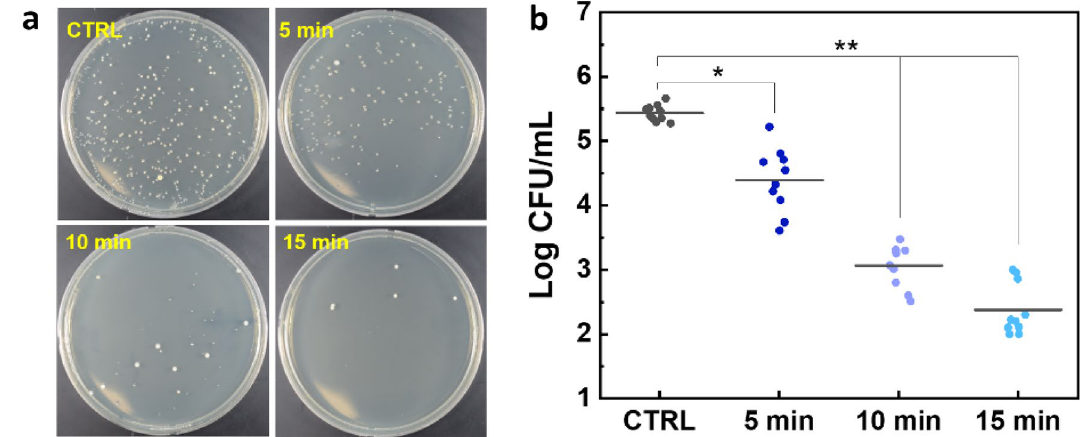
Figure 4. S. aureus bacterial inhibition after exposure of 405 nm laser at various irradiation times: ( a ) bacterial cells on agar plates (CTRL = control) and ( b ) quantification of bacterial removal in log CFU/mL ( * p < 0.05 and ** p < 0.01 vs. CTRL; N = 10).